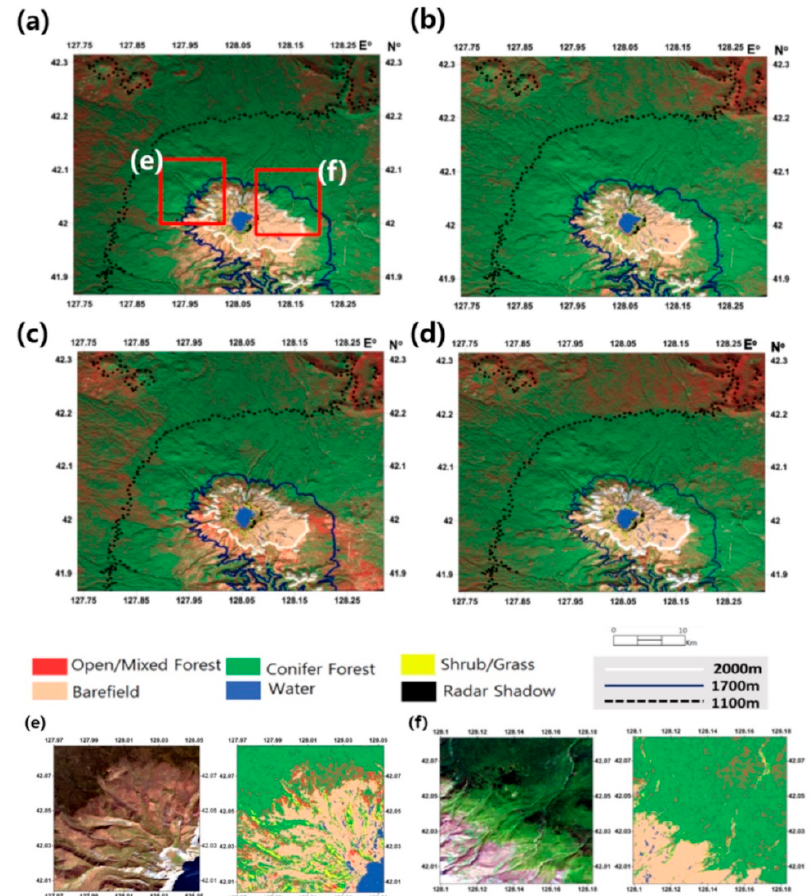
Figure 3. The land cover classifications with k-PCA plus SVM scheme over Mt. Baekdu from ( a ) HH1 packet during 2009/07–2010/03; ( b ) HH2 packet during 2010/03–2010/10; ( c ) HH3 packet during 2010/10–2011/03; ( d ) HH-HV packet during 2010/06–2010/10, and ( e – f ) LANDSAT sub-images and corresponding HH1 packet classifications.